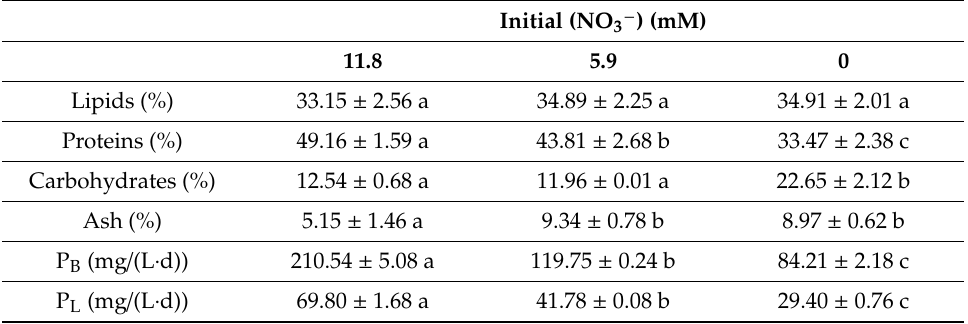
Table 5. E ff ect of the initial nitrate concentration on the biomass composition and